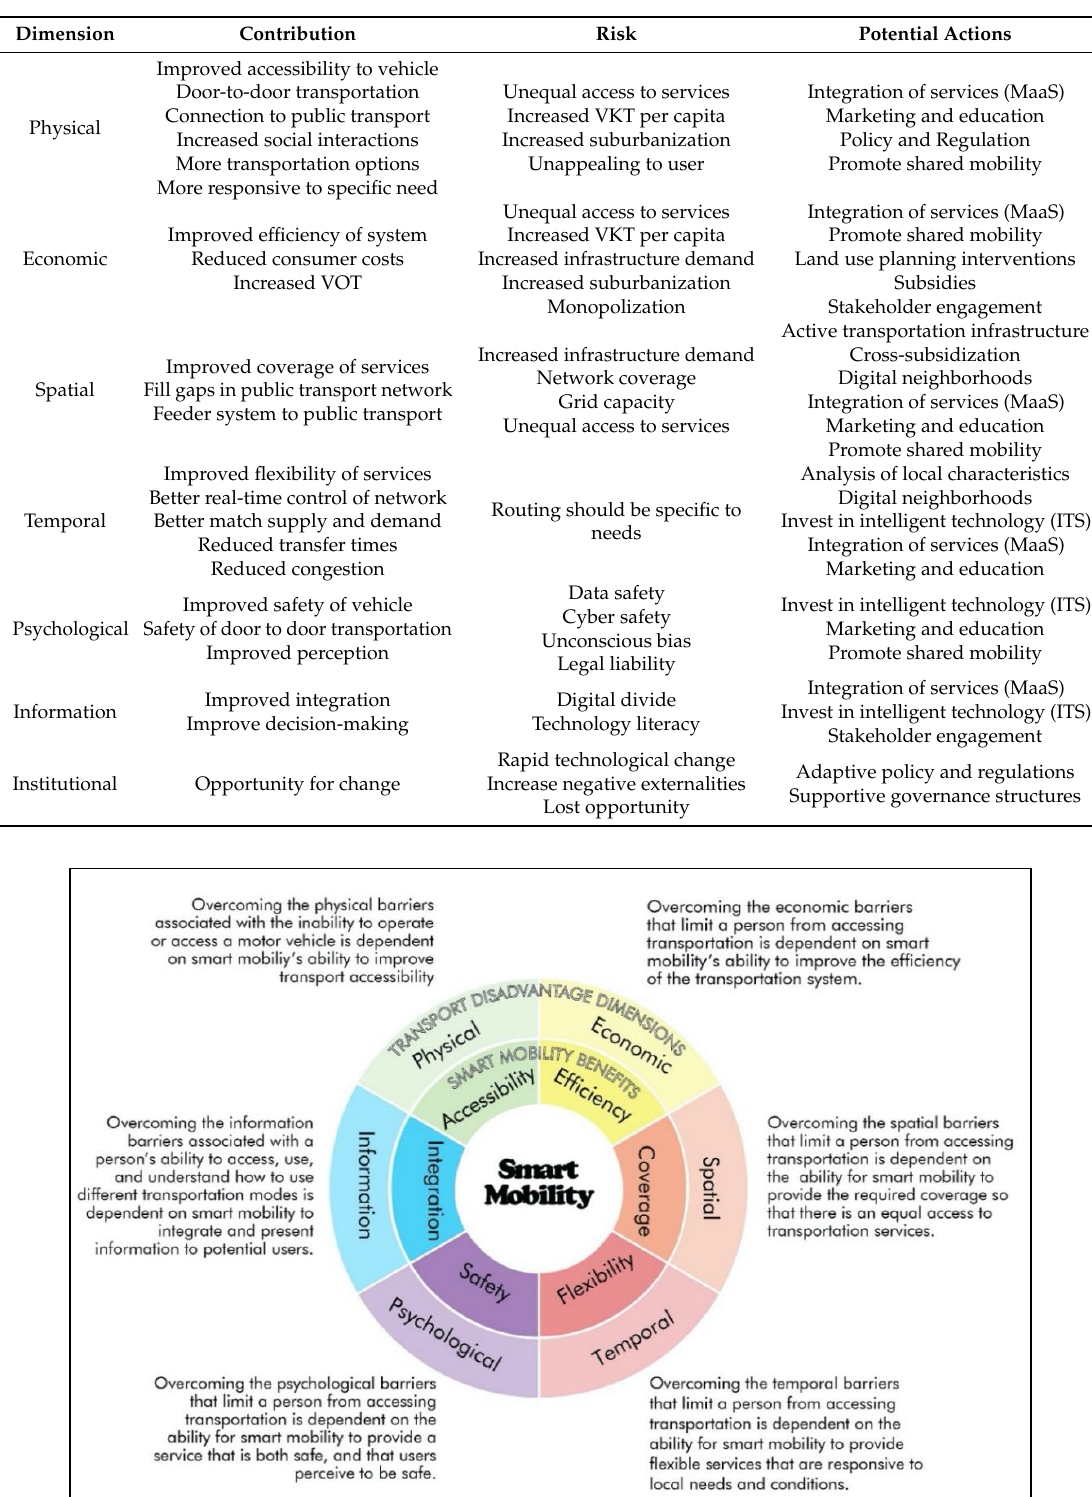
Table 3. Summary of literature review findings (source: authors).